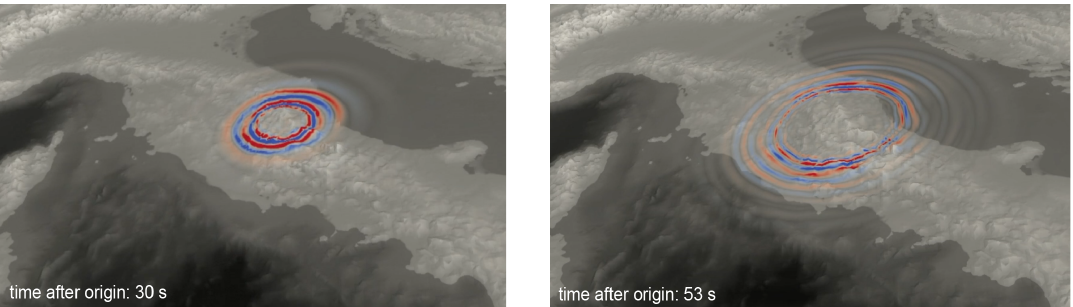
Figure 2: Snapshots at different time steps of the vertical-component velocity wavefield propagating along the sur- face. Red denotes positive (up) values and blue negative (down) values. The view is from the South. Wavefront distortions are mainly due to topographic effects and to the presence of 3D heterogeneities, see https: // youtu. be/ x6tDOjFGTs4 for full